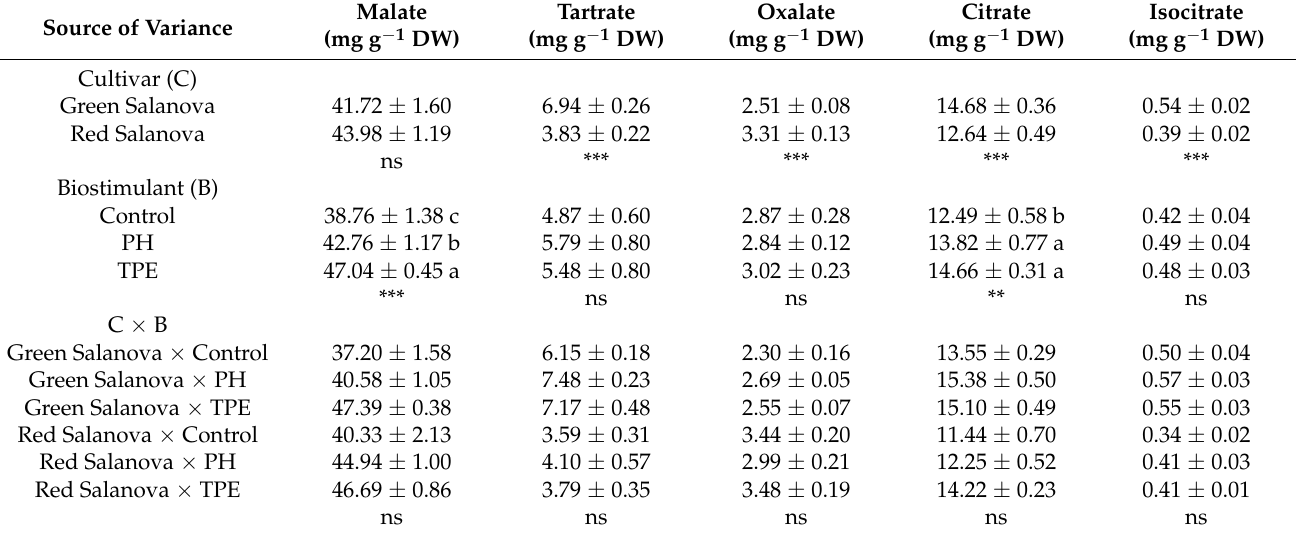
Table 3. Organic acids of red and green salanova lettuce and the influence of biostimulant